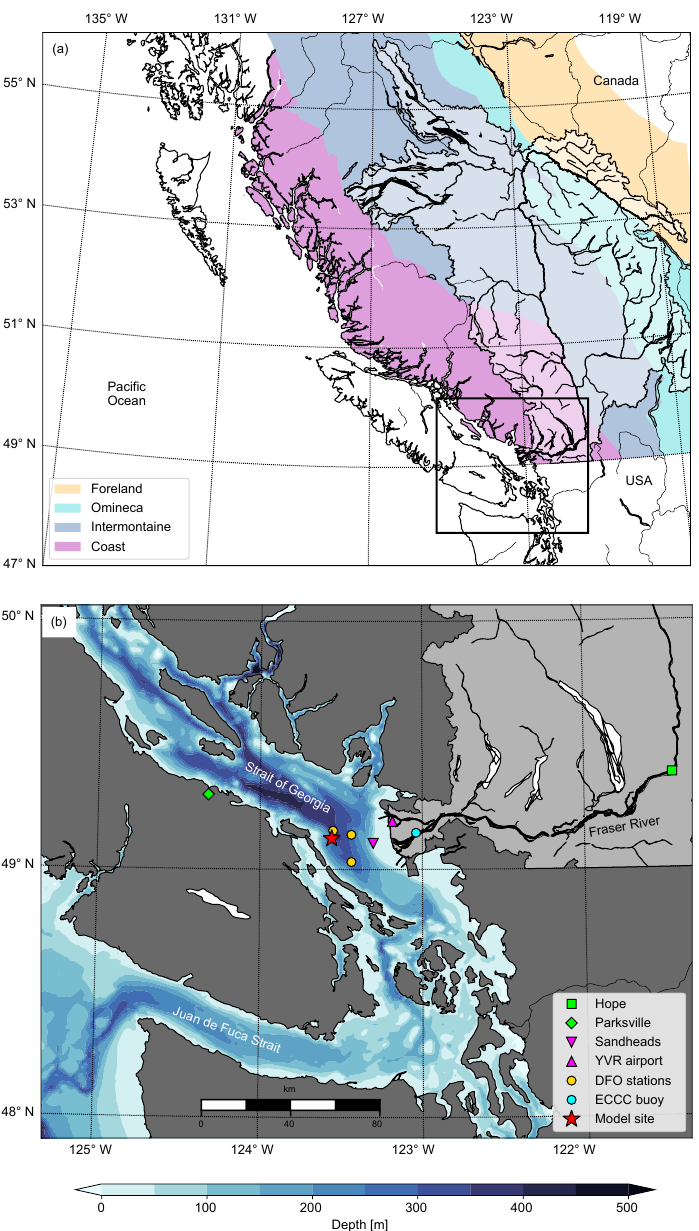
Figure 1. Maps of (a) the Fraser River watershed showing the major geologic belts (Wheeler et al., 1991), and (b) the lower Fraser River and Strait of Georgia showing the model location (red star), Environment and Climate Change Canada (ECCC) meteorological (Sandheads and YVR, magenta symbols) and river gauging (Fraser River at Hope and Englishman River at Parksville, green symbols) stations used to force the model, and Fisheries and Oceans Canada (DFO) sampling stations (yellow circles) and the ECCC Fraser River Water Quality Buoy (cyan circle) used to constrain Fraser River TA and pH,